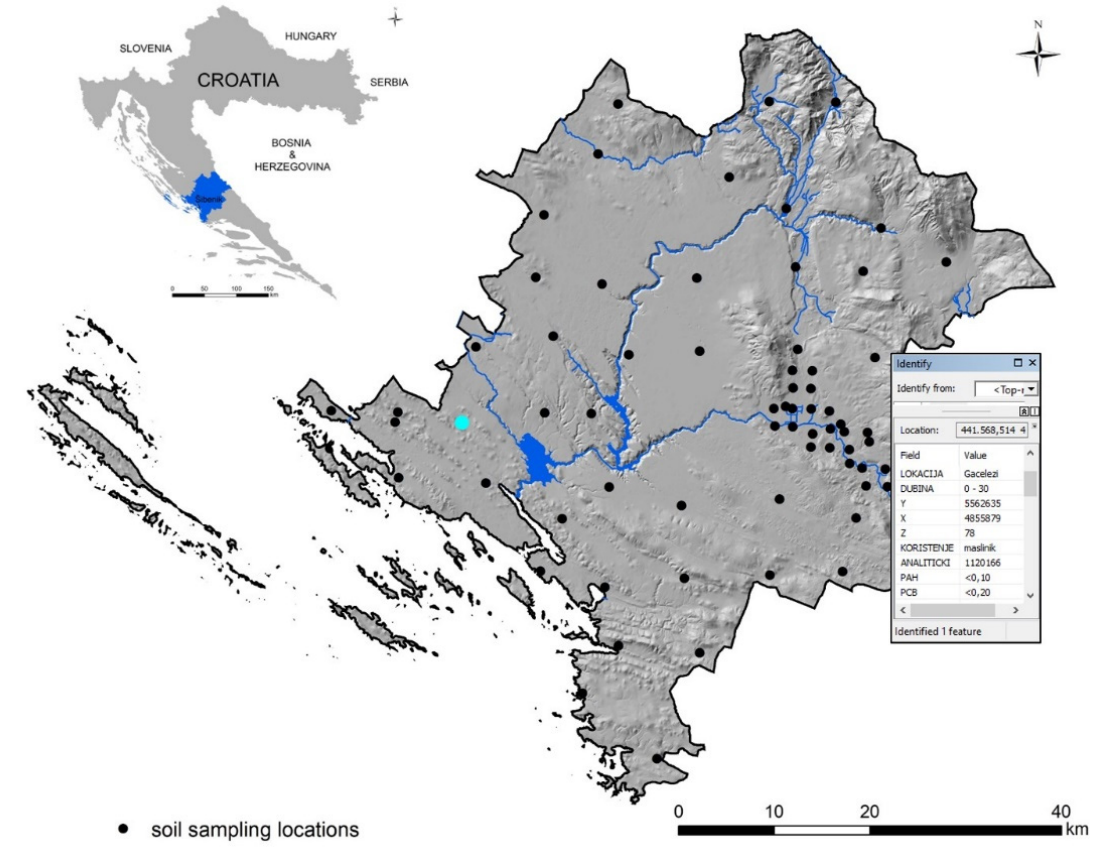
Figure 1. Geographical setting of the study area, surface soil sampling points and GIS sample point identify window (turquoise dot).